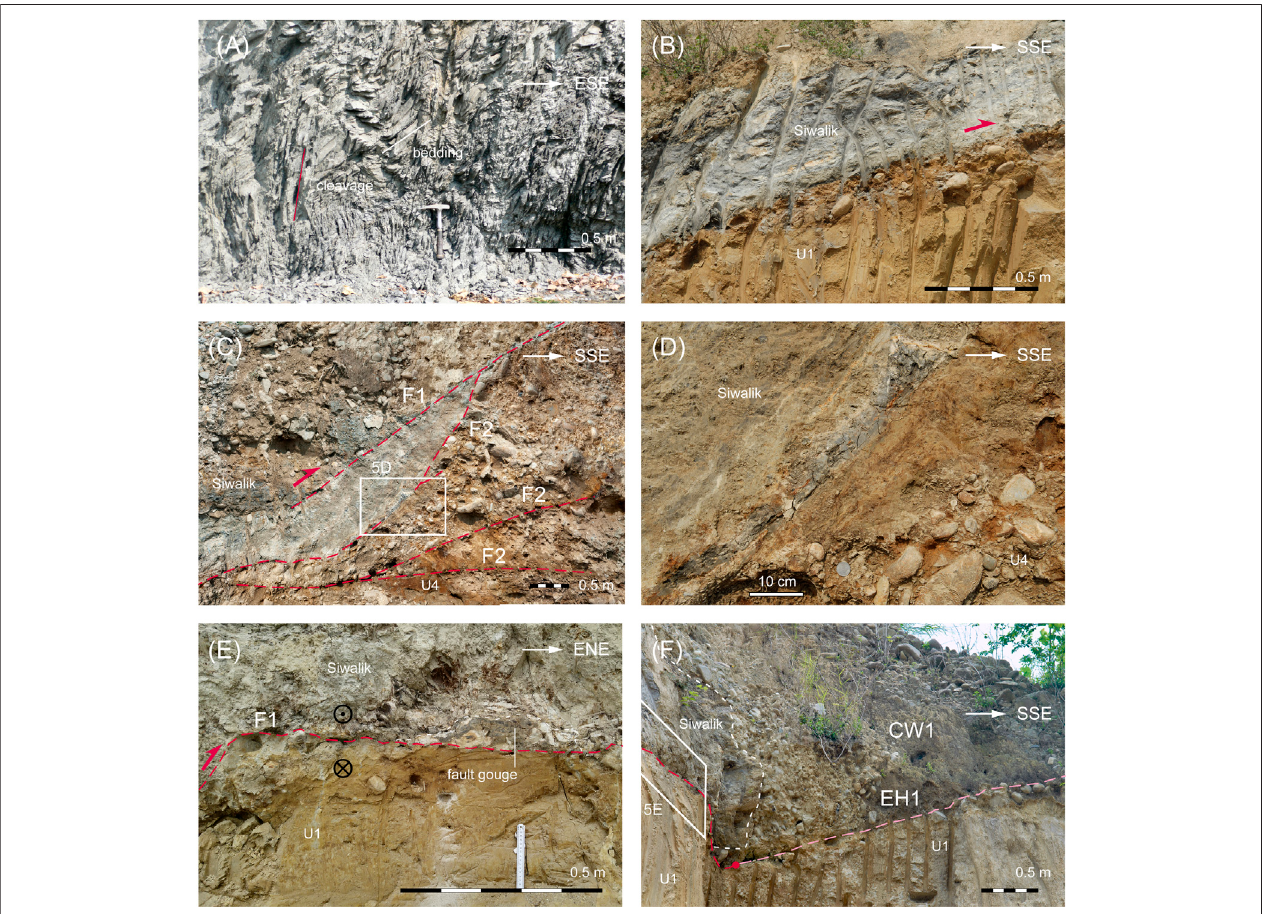
FIGURE 5 | Field photographs of characteristic structures at the Dungsam Chu MFT exposure. (A) Moderately west-dipping Siwaliks siltstone layering strongly overprinted by steeper fracture cleavage indicating top down to the west faulting. Location in the center of Samdrup Jongkhar indicated in Figure 2 . (B) F1 separating Siwaliks in the hanging wall and the U1 of terrace 2. Notice the layer of pebbles dragged up from lower stratigraphic levels. (C) Bottom of the north end of the paleoseismic exposure indicating branching of older faults F2 cut-off by the most recent fault F1. Between F1 and upper F2 is a lens of cataclasite. (D) Close up of Panel 5 (C) showing the cataclasite, which is derived both from Siwalik and T2 lithologies. Coin for the scale is in the middle bottom of the photograph. (E) Tip of the F1 fault, looking NNW. In the hanging wall, there is a lens of cataclasite, probably derived from Siwalik sediments, it the footwall, there are few pebbles as in Panel 5 (B) . (F) Colluvial wedge 1. Showing the tip of the F1 fault (circle), the leading edge of the Siwalik in the hanging wall (white dashed line), and the Event Horizon 1 (pale pink line). Location of the photograph in Panel 5 (D) is on the left side.